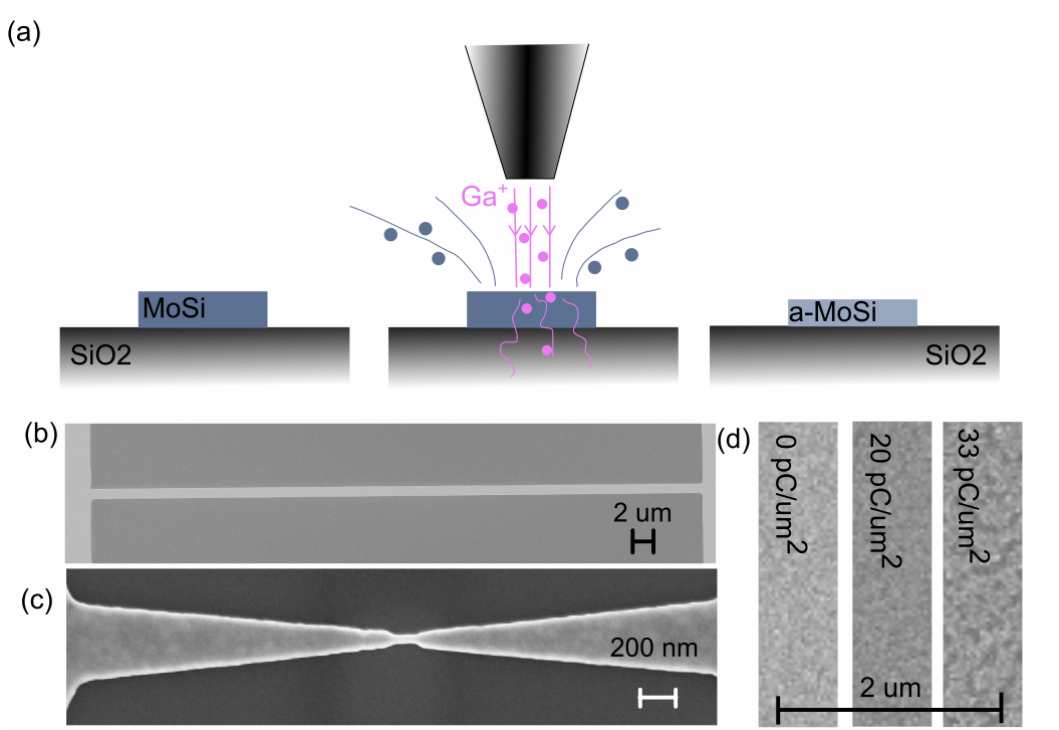
Figure 1. ( a ) Conceptual image of the irradiation of MoSi using focused ion beam. ( b ) Scanning electron micrograph showing the geometry for micrometer scale wires. ( c ) Scanning electron micrograph showing the geometry for nanometer scale samples. ( d ) Scanning electron micrographs with different FIB doses showing that surface roughness increases at doses larger than approximately 20 pC/ µ m 2 , but no visible effect is seen below that. We identify this dose as a threshold for significant film